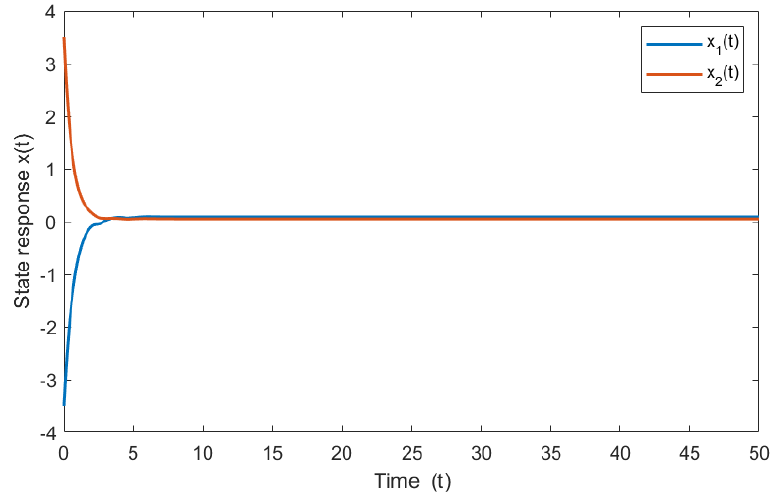
Figure 1. It provides the state response of system (4) under zero input and the initial condition [ − 3.5,3.5 ] . The interval time-varying delays are chosen as µ ( t ) = [ 3.6 + 0.9 | sin ( t ) | ] , and the activation function is set as f ( ξ ( t )) = [ 0.4 tanh ( x 1 ( t )) ,0.8 tanh ( x 2 ( t ))] T . Table 1. Allowable upper bound µ M for various µ d of Example